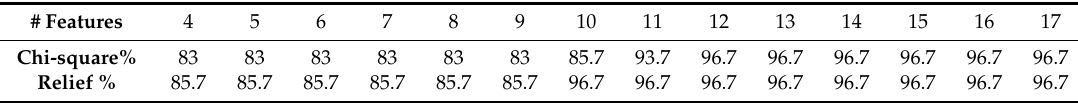
Table 8. Global accuracy. E ff ect of ranking features with Manhattan distance, MinPts = n /2, ε =